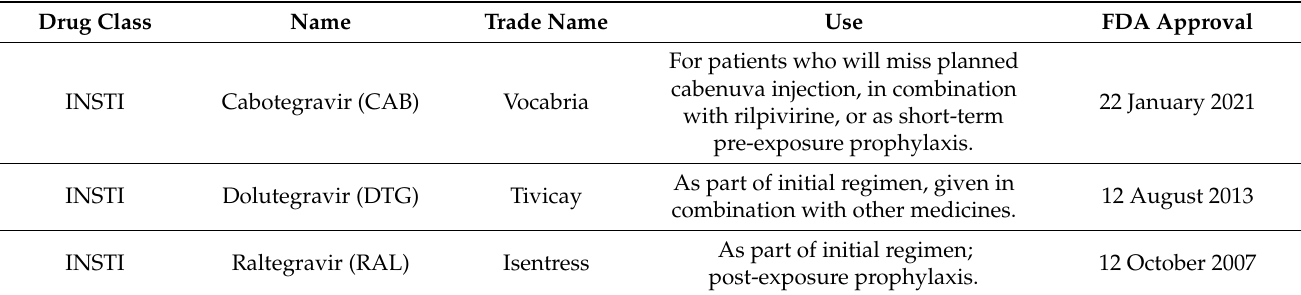
Table 5. Integrase strand-transfer inhibitors. (INSTI).